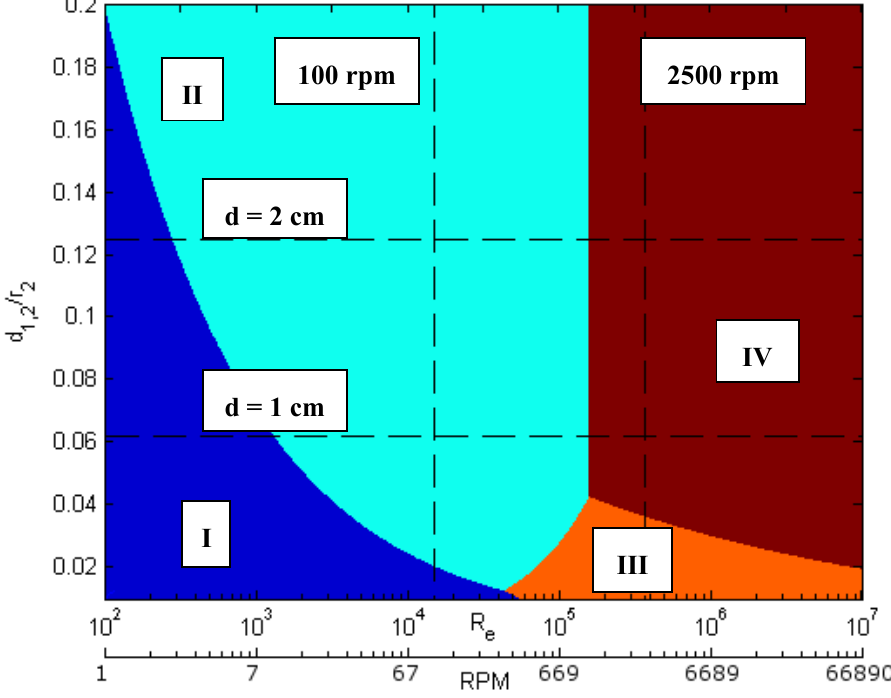
Figure 7. Theoretical flow regimes as function of Reynolds number (rotational speed) for the constructed geometry. The transition from region II to region IV was found to take place at a rotational velocity of around 905 rpm for spacing ratios higher than